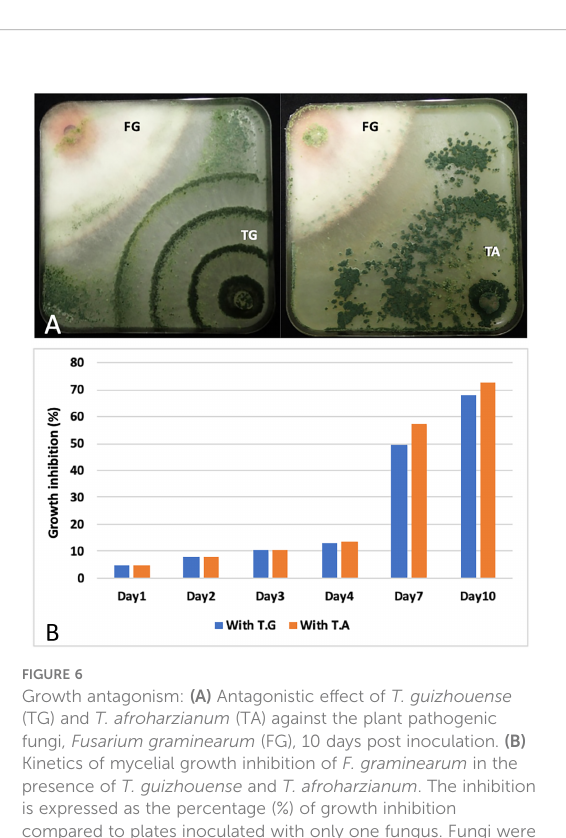
FIGURE 6 Growth antagonism: (A) Antagonistic effect of T. guizhouense (TG) and T. afroharzianum (TA) against the plant pathogenic fungi, Fusarium graminearum (FG), 10 days post inoculation. (B) Kinetics of mycelial growth inhibition of F. graminearum in the presence of T. guizhouense and T. afroharzianum . The inhibition is expressed as the percentage (%) of growth inhibition compared to plates inoculated with only one fungus. Fungi were inoculated in opposite corners of the square petri